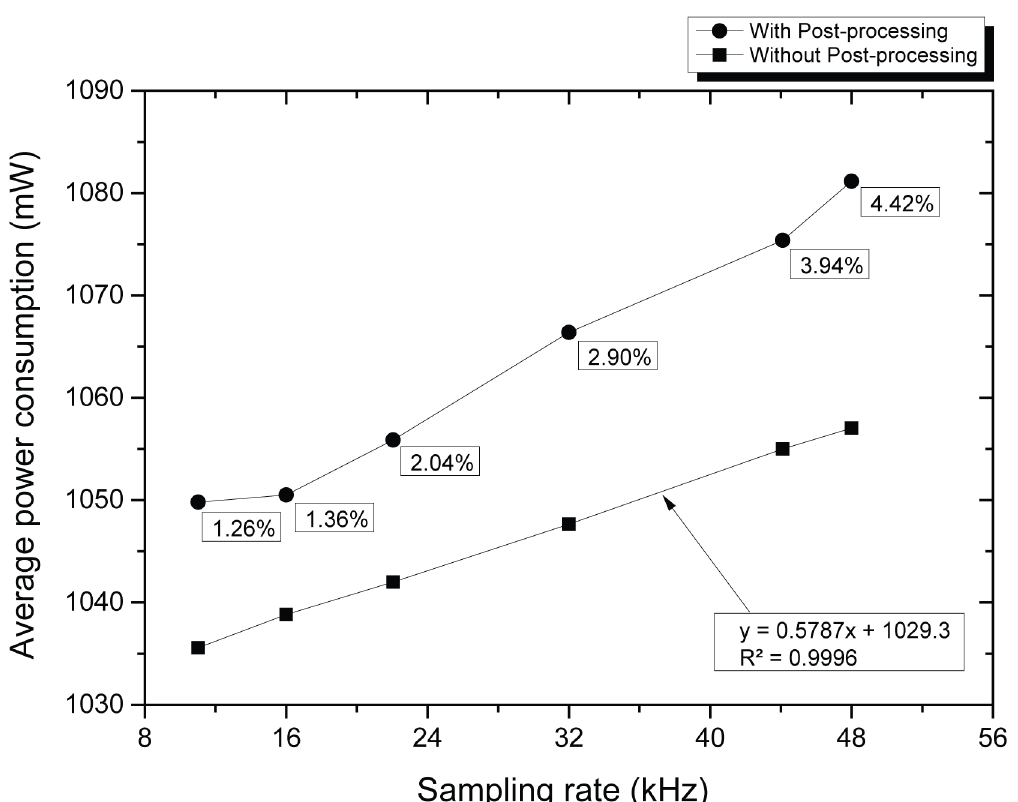
Fig 6. Average power consumption (at constant current) during continuous recordings made at different sample rates, with and without post- processing.